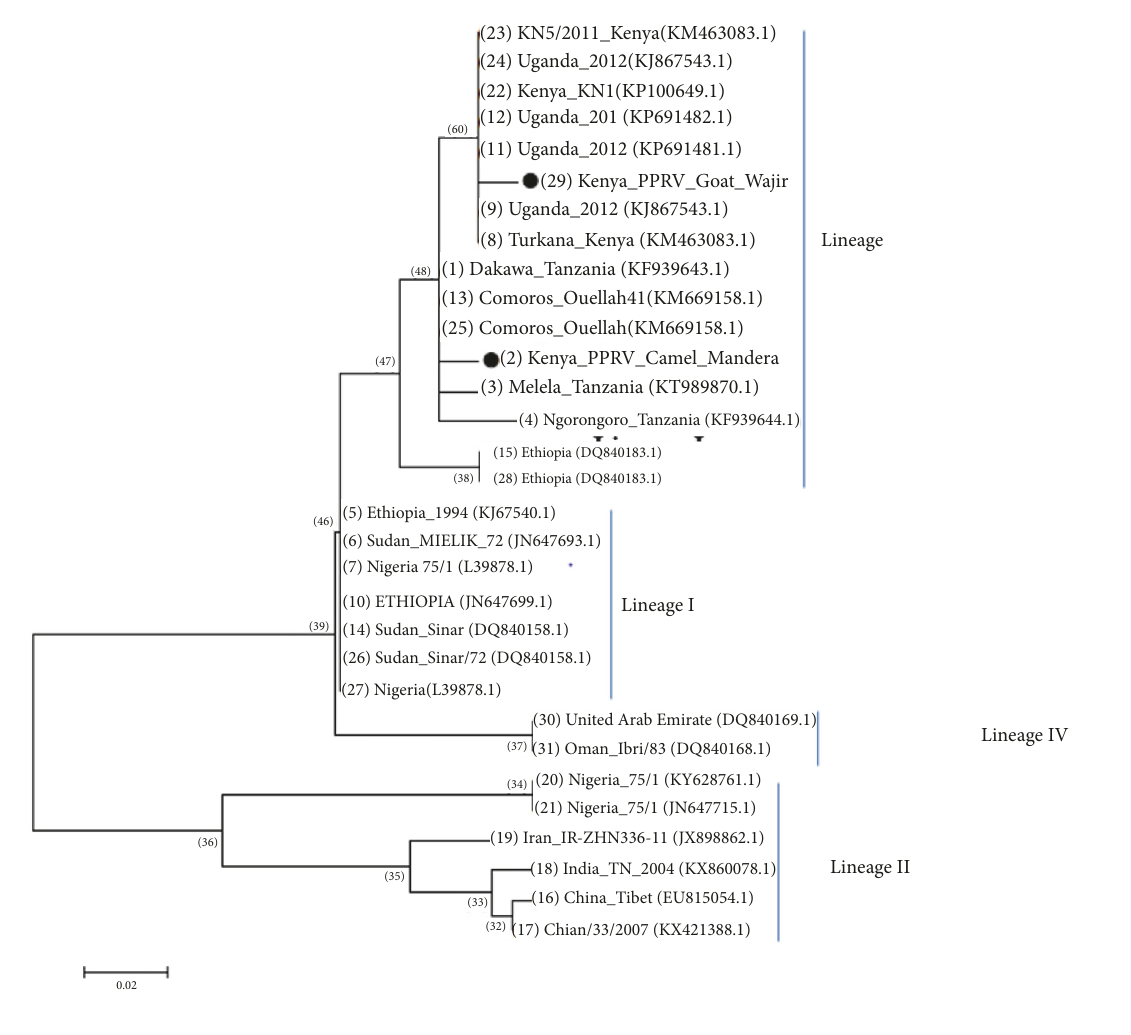
Figure 5: Phylogenetic tree of PPR viruses based on the N gene constructed using the neighbour-joining method in MEGA 7 (cid:2) software. The sample in this study is marked with a round black dot. Phylogeny was inferred following 1000 bootstrap